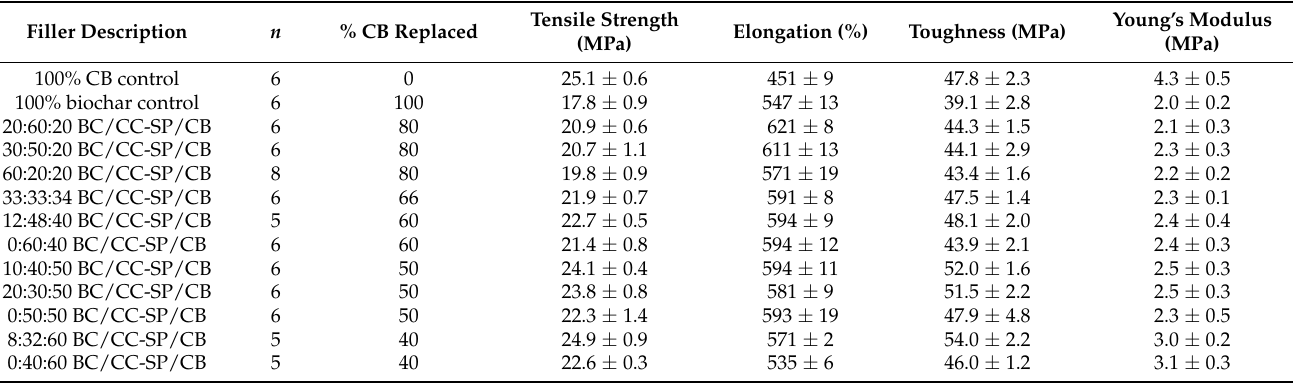
Table 3. Tensile properties of rubber composite